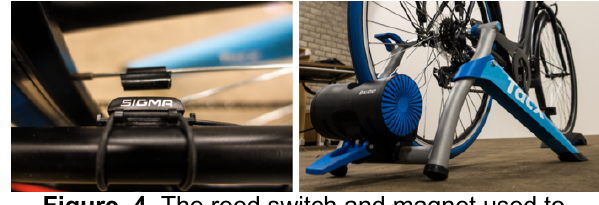
Figure. 4. The reed switch and magnet used to detect the rotational speed of the bike wheel (left) and the bike trainer used to provide resistance (right).